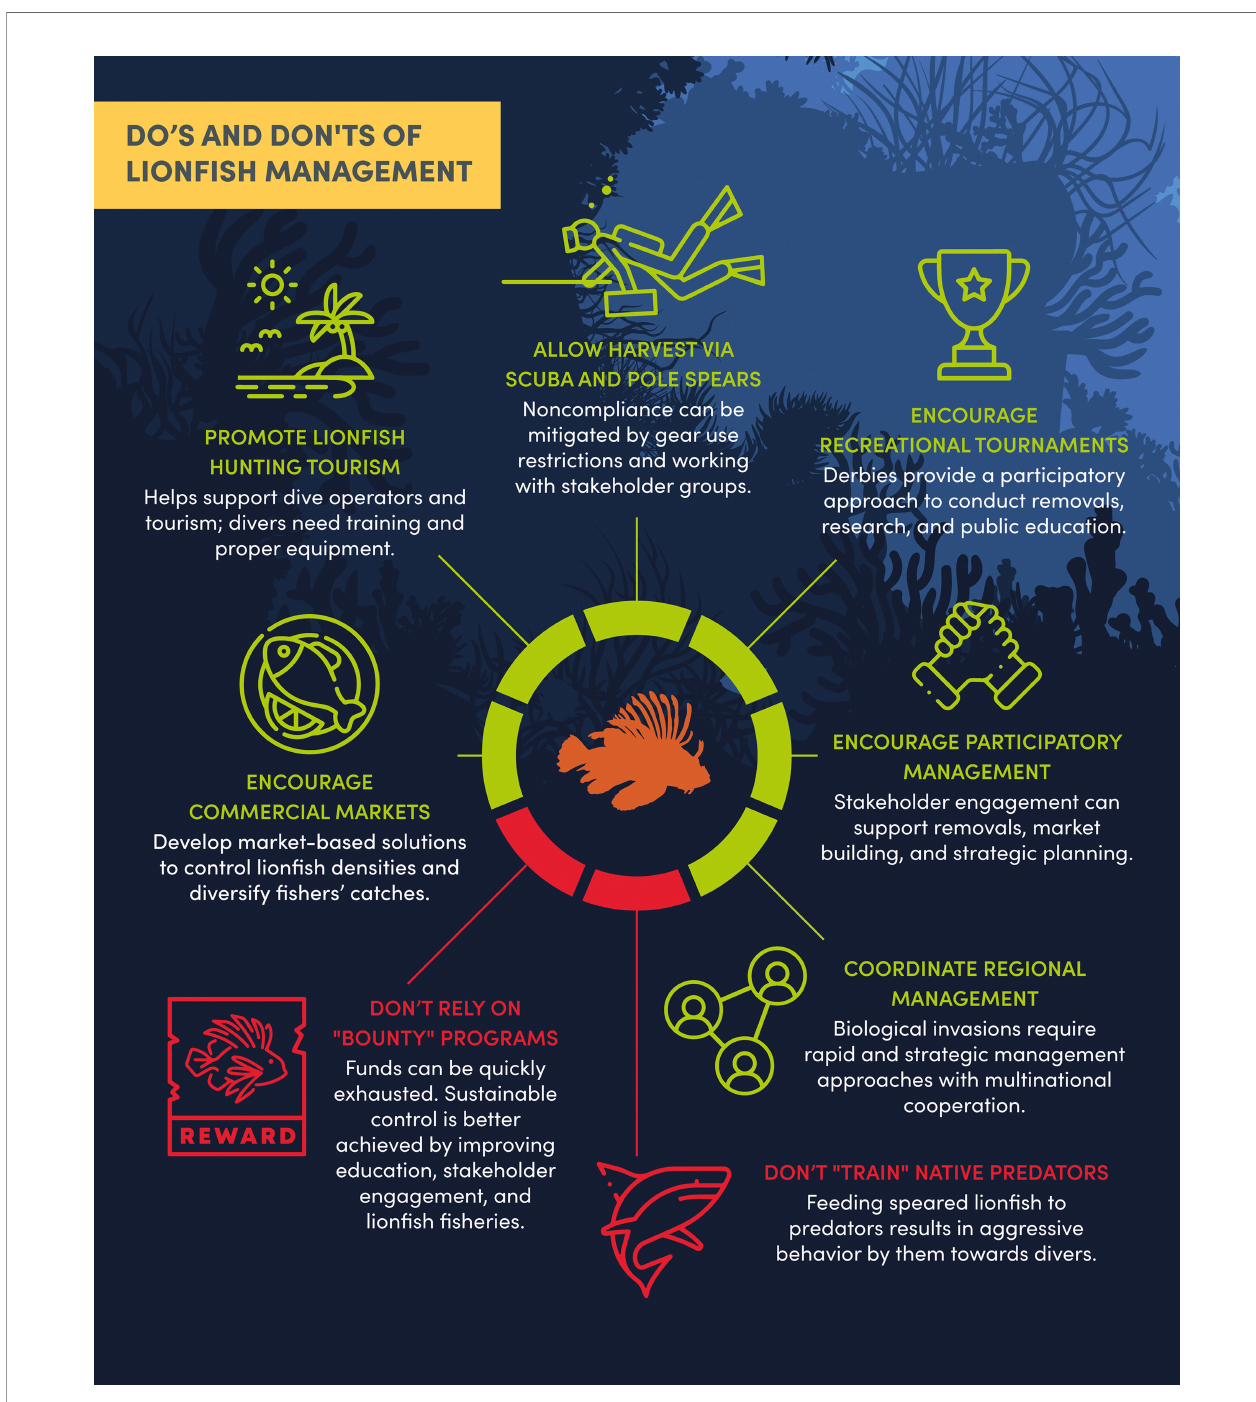
FIGURE 2 | Infographic summary of recommended and failed approaches for invasive lion fi sh